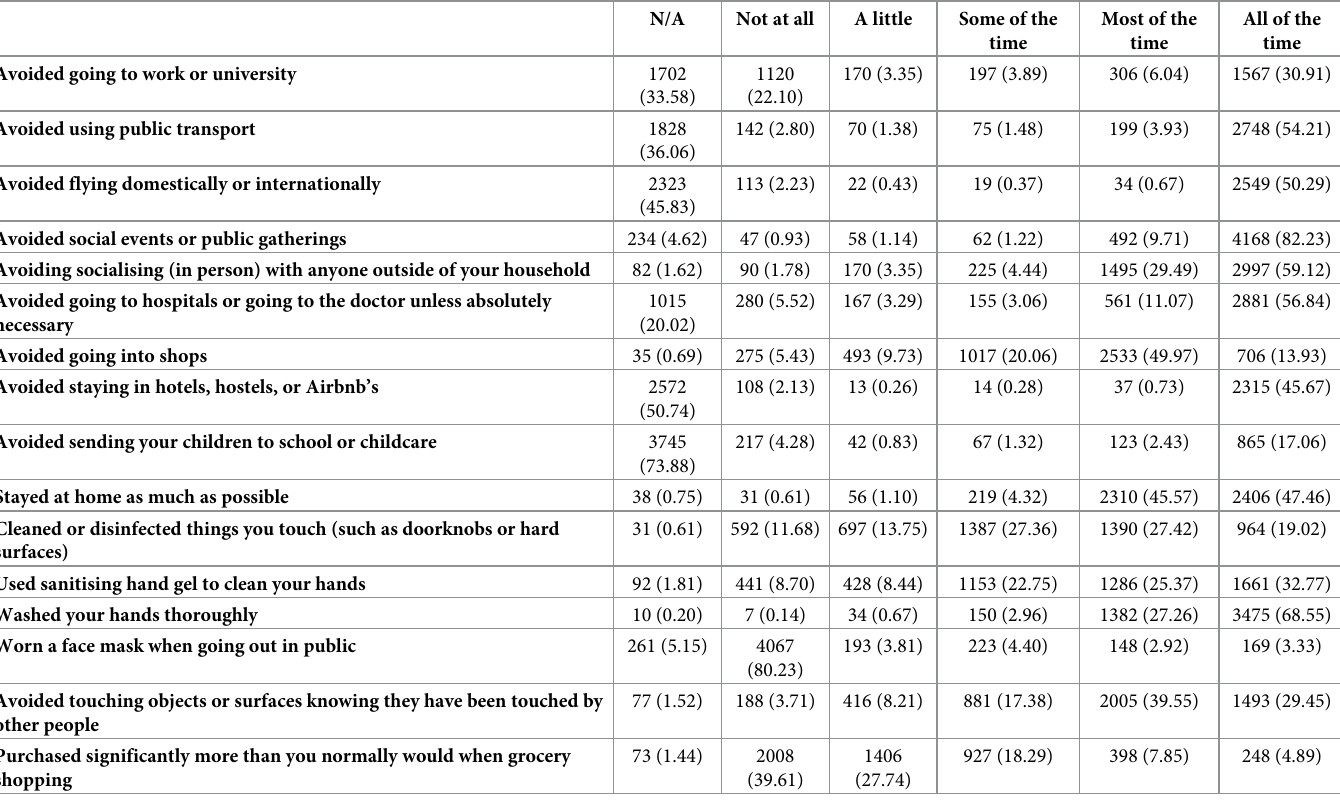
Table 2. Frequency of health-protective behaviours during the past week.